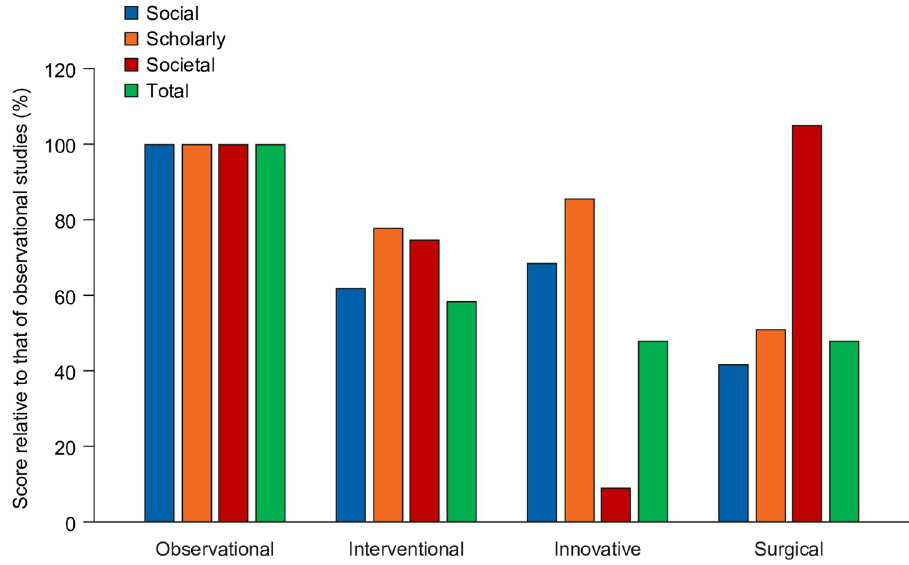
Fig 6. EMPIRE Index scores for NEJM Notable articles. EMPIRE Index scores are expressed as percentages of the scores achieved by observational